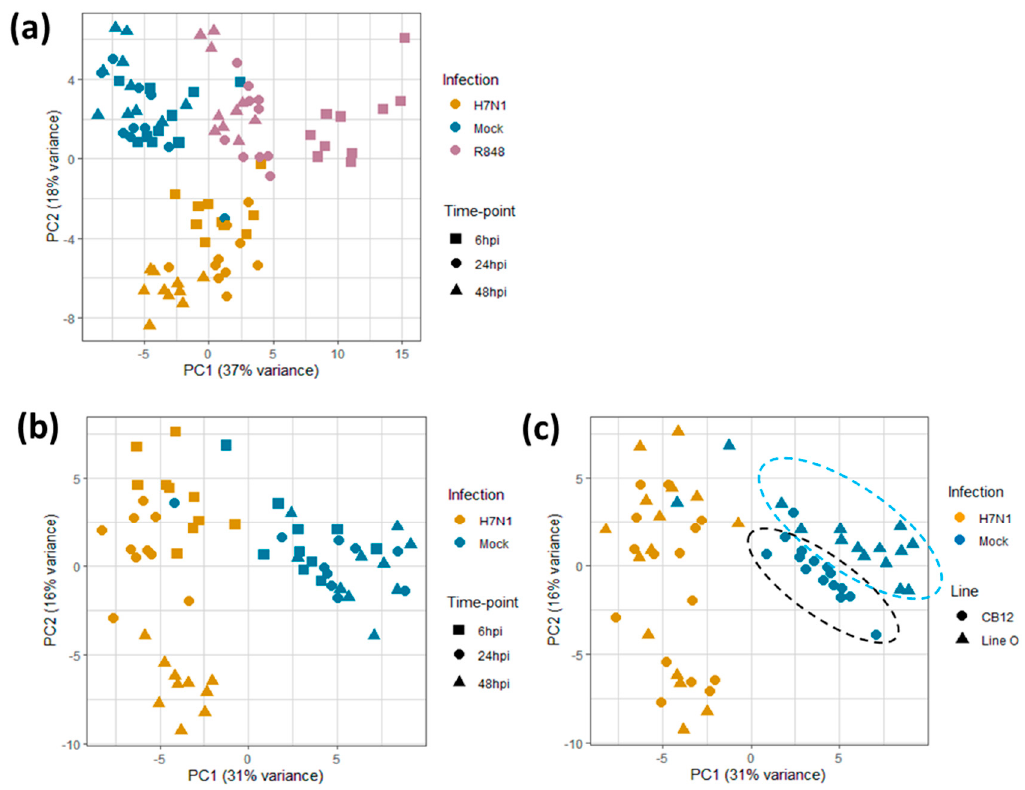
Figure 4. Principal component analysis (PCA) of the global gene expression of viral innate immune- related genes in lung macrophages using Fluidigm qPCR array. Lung macrophages were isolated from line 0 and line C.B12 and in vitro-infected or stimulated for 6, 24 or 48 h (n = five birds per line; three-way split over treatments and timepoints). ( a ) PCA plot of collated data from line 0 and line C.B12 showing clustering of the samples in terms of infection/stimulus: H7N1-infected (orange), mock (blue) and R848-stimulated (pink). ( b , c ) PCA plots of lung macrophages infected with H7N1 (orange) or mock (blue) indicate clusters and transcriptional differences in gene expression related to the ( b ) timepoint and ( c ) genetic line, with the C.B12 cluster highlighted in a black-dashed ellipse and the line 0 cluster highlighted in a blue-dashed ellipse.